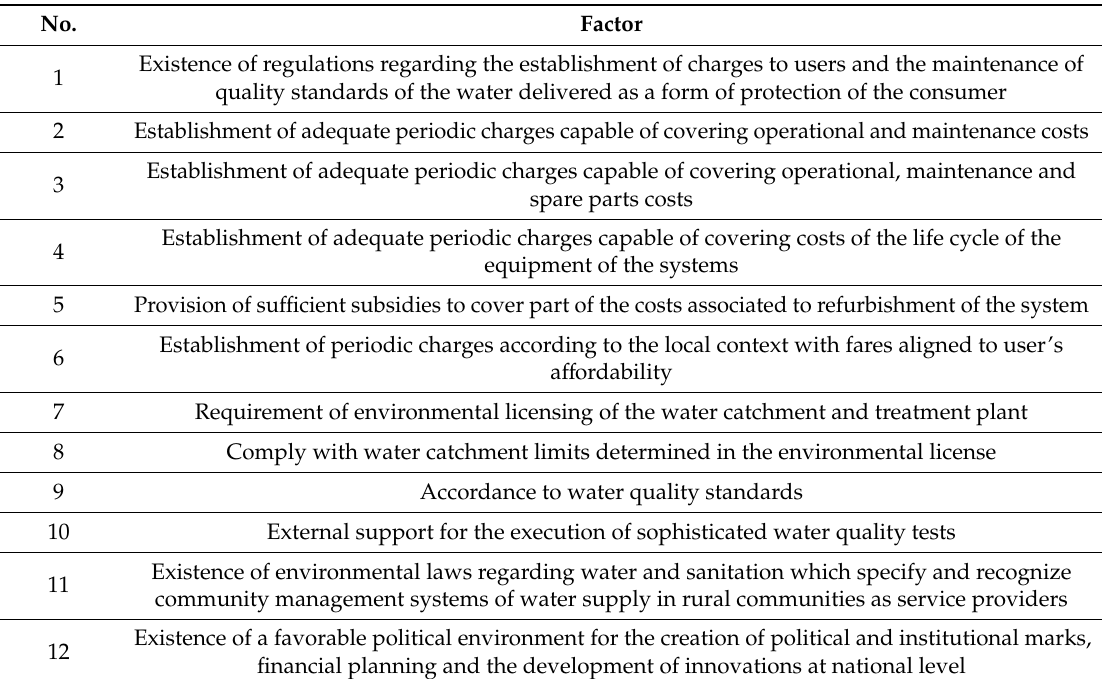
Table 1. Display of the 30 critical factors associated with successful cases of the community management model of rural water